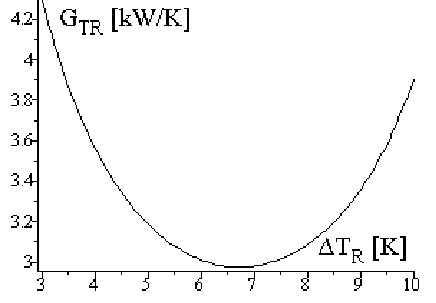
Figure 14. G TE dependence of Δ T H —case “a”. G TEmin = 1.443 kW/K for Δ T H = 231 K.